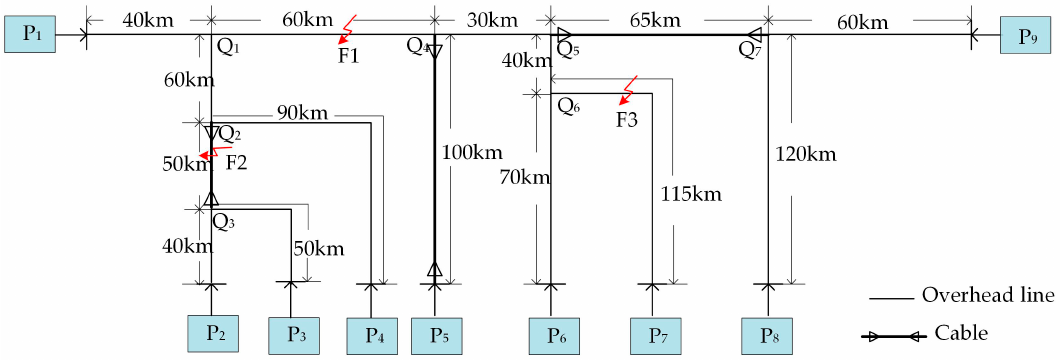
Figure 8. Nine-terminal hybrid line simulation system. Table 1. Parameters of lines.